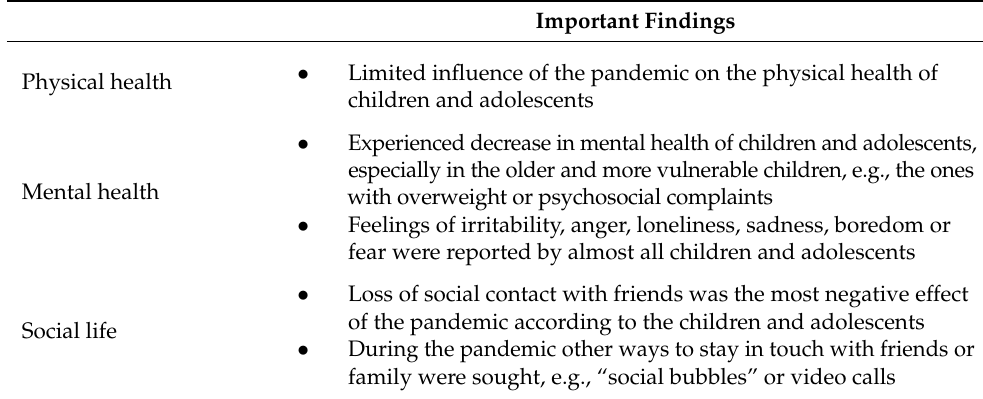
Table 3. Important findings with regard to the wellbeing of families during the COVID-19 pandemic. Important